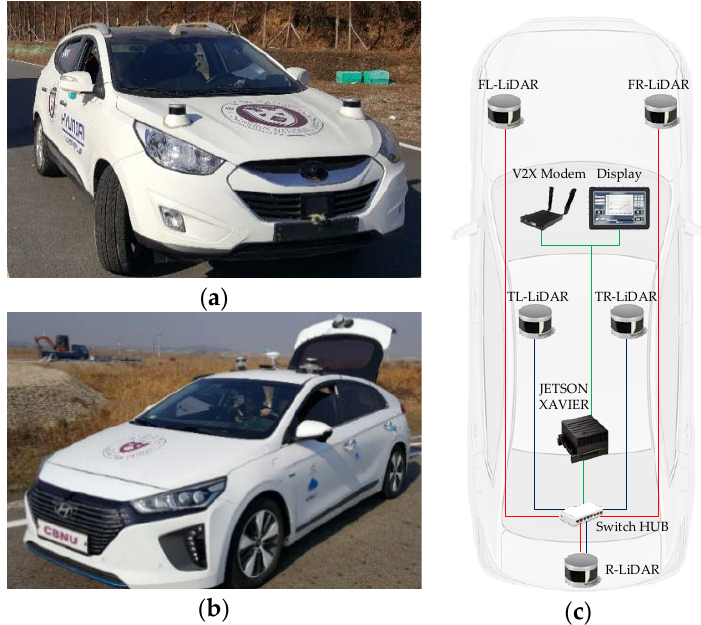
Figure 2. ( a ) TUCSON Platform; ( b ) IONIQ Platform; ( c ) LiDAR setup (connections in red-green are for the TUCSON and blue-green are of the IONIQ).